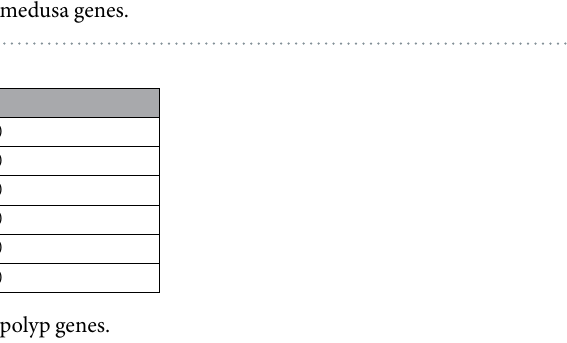
Table 2. Dilution curves of the tested medusa genes.